Question: Summarize what this figure shows in one sentence.
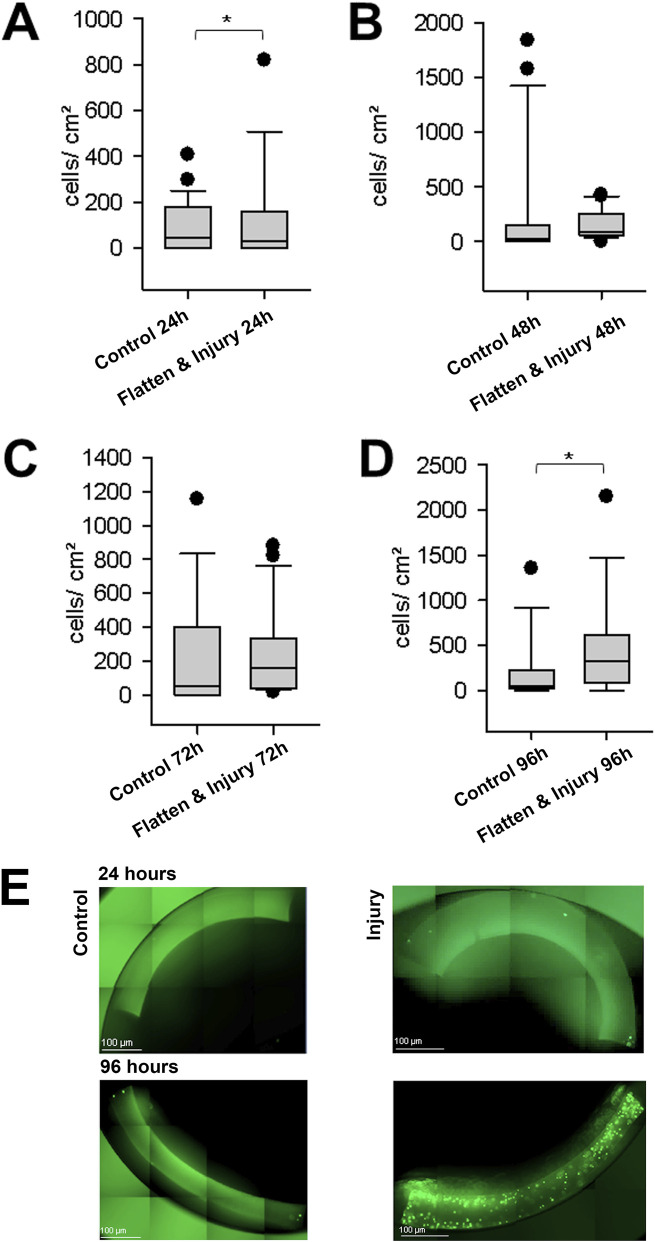
Answer: Proliferating cells after flattening of superficial zone discs followed by a single injurious compression (65%) 24, 48, 72, and 96 h after injury. Results for control discs and for flattened and injured discs at (A) 24 h (B) 48 h (C) 72 h, and (D) 96 h that were incubated in medium containing Click. It™-EdU, fixed and permeabilized on the respective days, showing proliferating cells as number of EdU-stained cells per disc per um 2 . Injury consisted of a single uniaxial unconfined compression (65% final strain, 100%/s strain rate). 24 h: control n = 24 (4 donors), injury n = 18 (4 donors); 48 h: control n = 21 (4 donors), injury n = 21 (4 donors); 72 h: control n = 17 (4 donors), injury n = 22 (4 donors); 96 h: control n = 18 (4 donors), injury n = 19 (4 donors). Here, n denotes the number of analyzed half-discs. The * indicates a significant difference between groups (p < 0.05) (E) Representative images of proliferation in superficial zone discs in control and injured discs after 24 and 96 h. Scale bar: 100 µm.